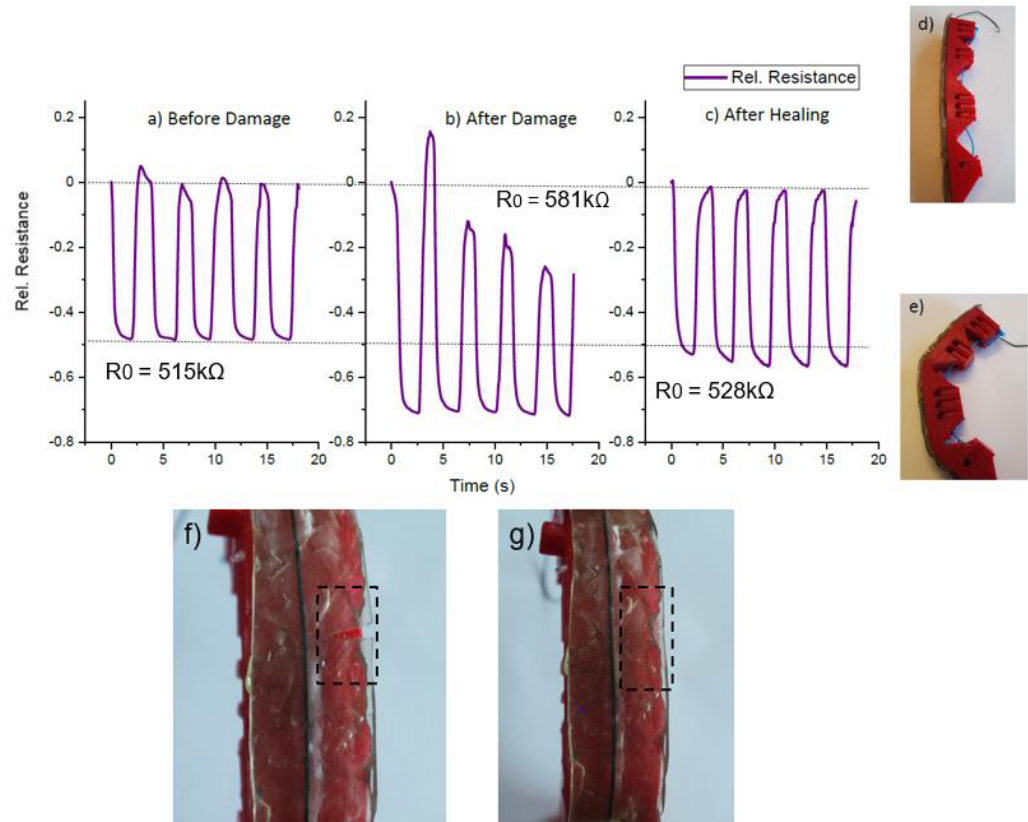
Figure 9. The electrical signal from the piezoresistive sensor in the skin during the dynamic bending (0–50% tension based on the change in the length of the tendon) for the tendon-based soft actuator in five repeated cycles ( a ) before and ( b ) after partial damage of the ShSFC matrix, and ( c ) after the healing of the ShSFC matrix. ( d ) The tendon-based soft actuator in the initial position and ( e ) in a bent position. The tendon based-soft actuator with ( f ) partially damaged and ( g ) healed ShSFC-based skin.